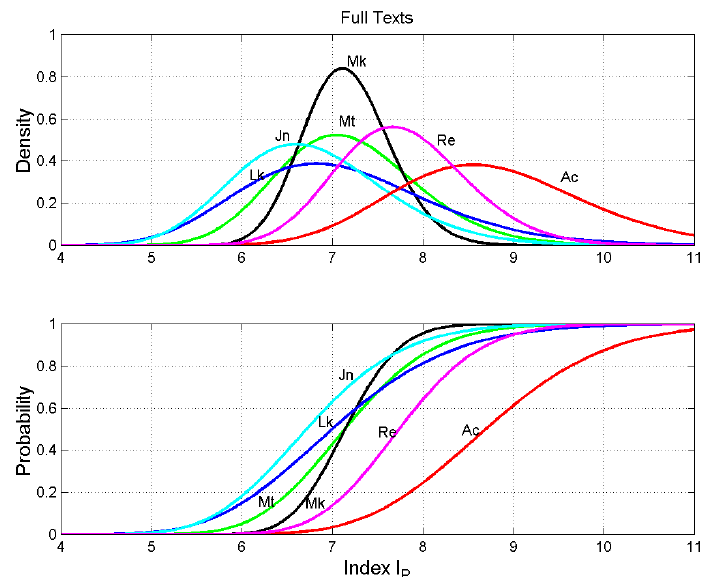
Figure 4. Probability density functions (upper panel) and probability distribution functions (lower panel) of the number of words per sentence 𝐼 𝑃 . Matthew : green line; Mark: black line; Luke : blue line; John : cyan line; Acts : red line; Revelation : magenta line.